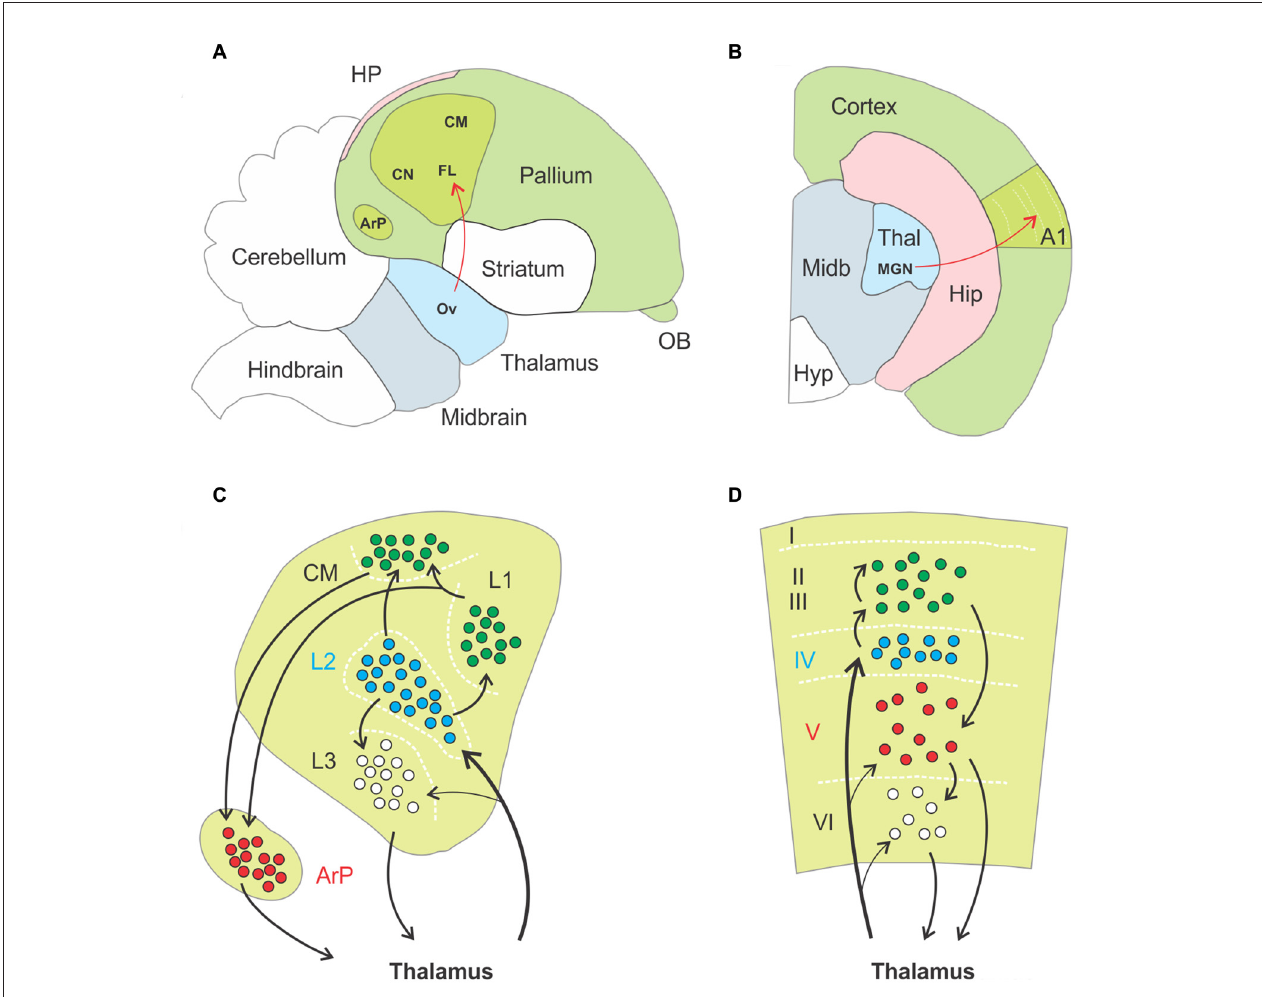
FIGURE 4 | Anatomo-functional homologies between avian and mammalian brain. (A,B) Schematic drawings of a parasagittal section through the brain of a zebra finch, (A , adapted from Jarvis et al., 2005) and a coronal section through the hemisphere of a mouse (B) , respectively. Basic anatomical compartments present on both schematic drawings are color coded (as opposed to white). The primary auditory areas are highlighted in apple green as an example of functional homologies between both species, ascending thalamopallial and thalamocortical pathways indicated in red. Abbreviations: A1, primary auditory cortex; ArP, arcopallium; CM, caudal mesopallium; CN, caudal nidopallium; FL, field L of the nidopallium; HP, hippocampal complex; Hip, hippocampus; Hyp, hypothalamus; MGN, medial geniculate nucleus; Midb, midbrain; OB, olfactory bulb; Ov, nucleus ovoidalis; Thal, thalamus. (C,D) Schematic drawings of the functional organization of the auditory pallium (C) and primary auditory cortex (D) , respectively. Black arrows indicate excitatory connections, dashed white lines highlight approximate borders between pallial nuclei (C) and cortical layers (D) . Roman numerals label individual layers. Proposed homologies between discrete nuclei and layers are color coded. Thalamorecipient, RORß expressing neurons are labeled in blue, and projection neurons positive for ER81 in red. In both species these populations are linked by intermediate excitatory neurons located more superficially, in subfield L and the caudal mesopallium in birds and in supragranular layers in rodents. Abbreviations: ArP, arcopallium; CM, caudal mesopallium; L1, L2, L3, subfields L1, L2, L3 of the